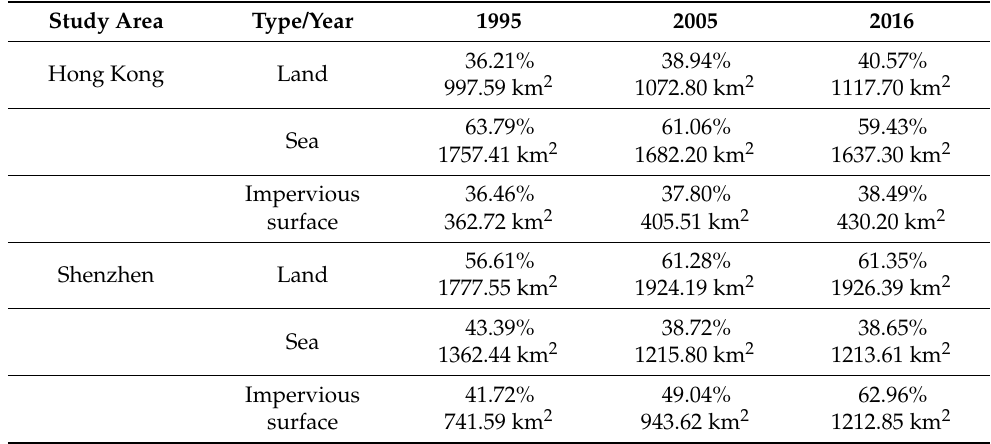
Figure 15. Trends of land, sea, and impervious surface. Table 5. Percentage and area of land, sea, and impervious surface of Hong Kong and